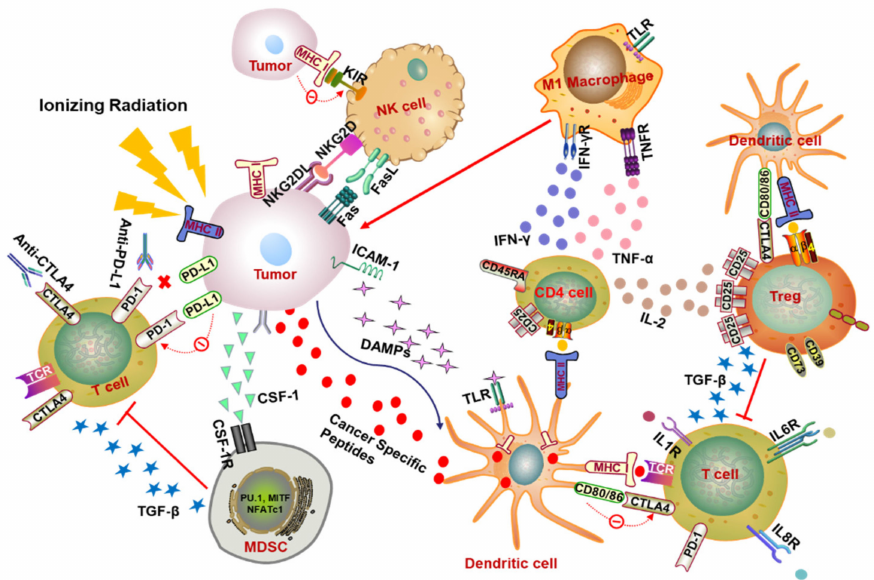
Figure 1. Radiotherapy-mediated immunomodulation of tumor microenvironment. In the immune activation e ff ect, RT triggers the tumor to release DAMPs, which can bind to TLR4 on the surface of DCs to enhance the ability of DCs to present the major histocompatibility complex class I (MHC-I) molecules and promote the maturation of DCs and the activation of T cells. Irradiation also activates CD4 + T cells by increasing the presentation of MHC-II by APCs (e.g., DCs) and expedites the di ff erentiation of M1 macrophages by secreting pro-inflammatory factors such as IFN- γ and TNF- α to promote tumor phagocytosis. On the other hand, the immunosuppressive e ff ect also exists after radiation. Both IL-2 secreted by CD4 + T cells and MHC-II binding to Treg surface receptors contribute to the activation of immunosuppressive Treg cells. The combination of CTLA-4 and CD80 / 86 also promotes the activation of Treg when they have opposite e ff ects on the activation of T cells. Subsequently, Treg exhibits an immunosuppressive role by releasing signaling factors such as TGF- β to inhibit T cell activation. Ionizing radiation (IR) can also cause the accumulation of immunosuppressive MDSCs in the tumor microenvironment by receiving CSF-1 and other factors released by the tumor and exerts its